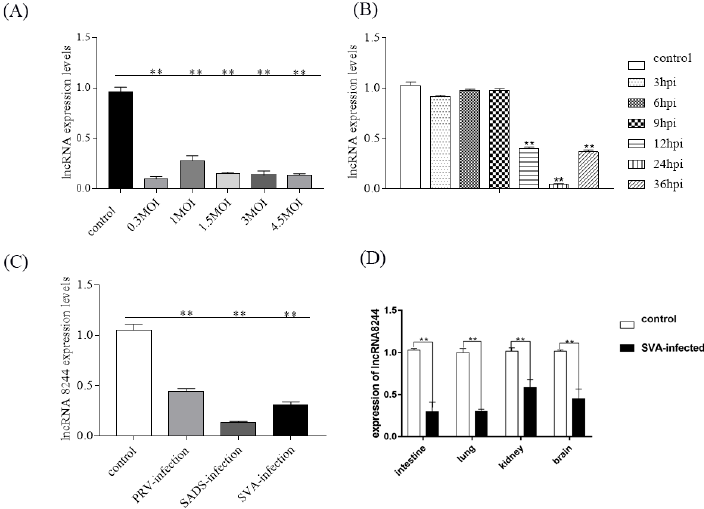
Figure 1. The expression of lncRNA 8244 in cells or clinical samples. ( A ) PK-15 cells were infected or no-infected with SVA (MOI = 0.3, 1, 1.5, 3, 4.5) for 24 h. Total RNA was extracted to determine the relative mRNA expression of lncRNA 8244 by real-time RT-PCR assay. ( B ) PK-15 cells were no- infected or infected with SVA (MOI = 1.5). The mRNA expression of lncRNA 8244 at 3, 6, 9, 12, 24, 36 hpi. ( C ) The expression level of lncRNA 8244. ( D ) Expression of lncRNA 8244 in clinical samples of SVA-infected piglets. Total RNA was extracted to determine the relative mRNA expression of lncRNA 8244 with real-time RT-PCR assay. All data are represented as mean ± SD with three repli- cates. ** p < 0.01.